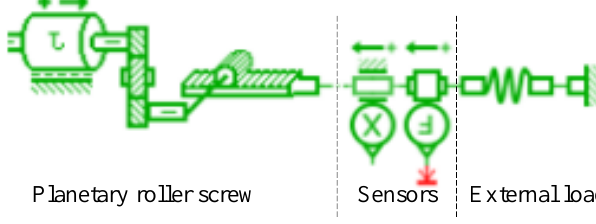
Figure 3. Mechanical assembly model.